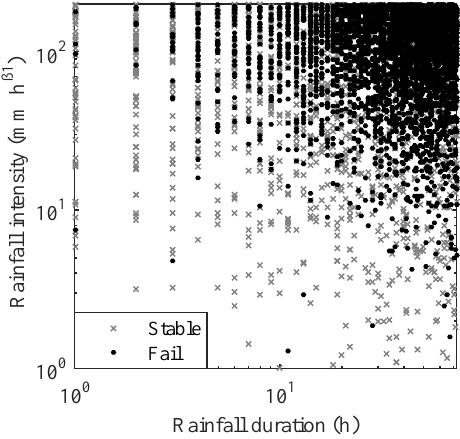
Figure 8. Sampled values of rainfall intensity versus rainfall du- ration when effective cohesion over thickness of topsoil is smaller than 2.0kPam − 1